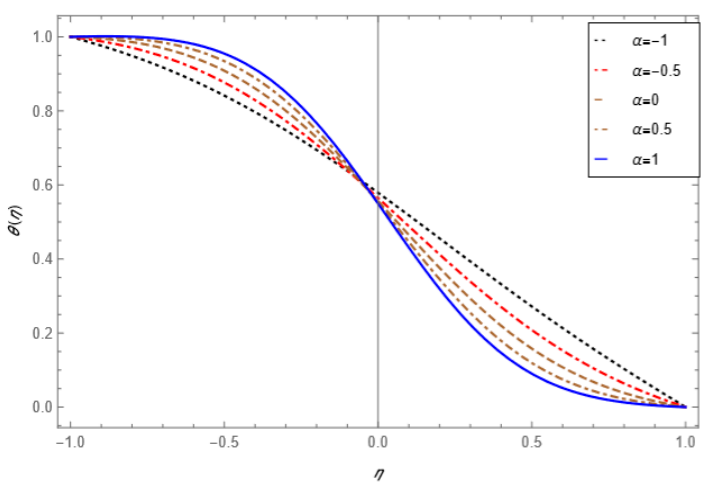
Figure 2. Expansion ratio effect on a temperature profile for ϕ 1 = ϕ 2 = 0.01, Pr = 6.2, σ = 0.1. Figure 2: Expansion ratio effect on a temperature profile for 𝜑 (cid:2869) = 𝜑 (cid:2870) = 0.01, Pr =6.2, 𝜎 = 0.1 . Figure 2: Expansion ratio effect on a temperature profile for 𝜑 (cid:2869) = 𝜑 (cid:2870) = 0.01, Pr =6.2, 𝜎 = 0.1 .